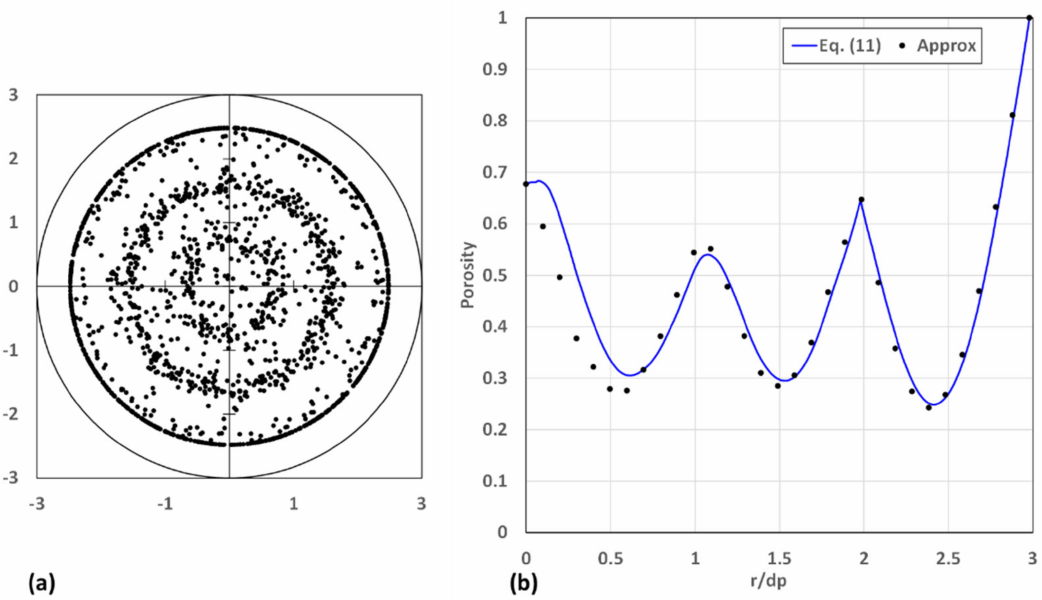
Figure 8. ( a ) Positions of centres of the spheres and ( b ) the radial variations in porosity based on Equation (11) and the approximate expression for D / d p =